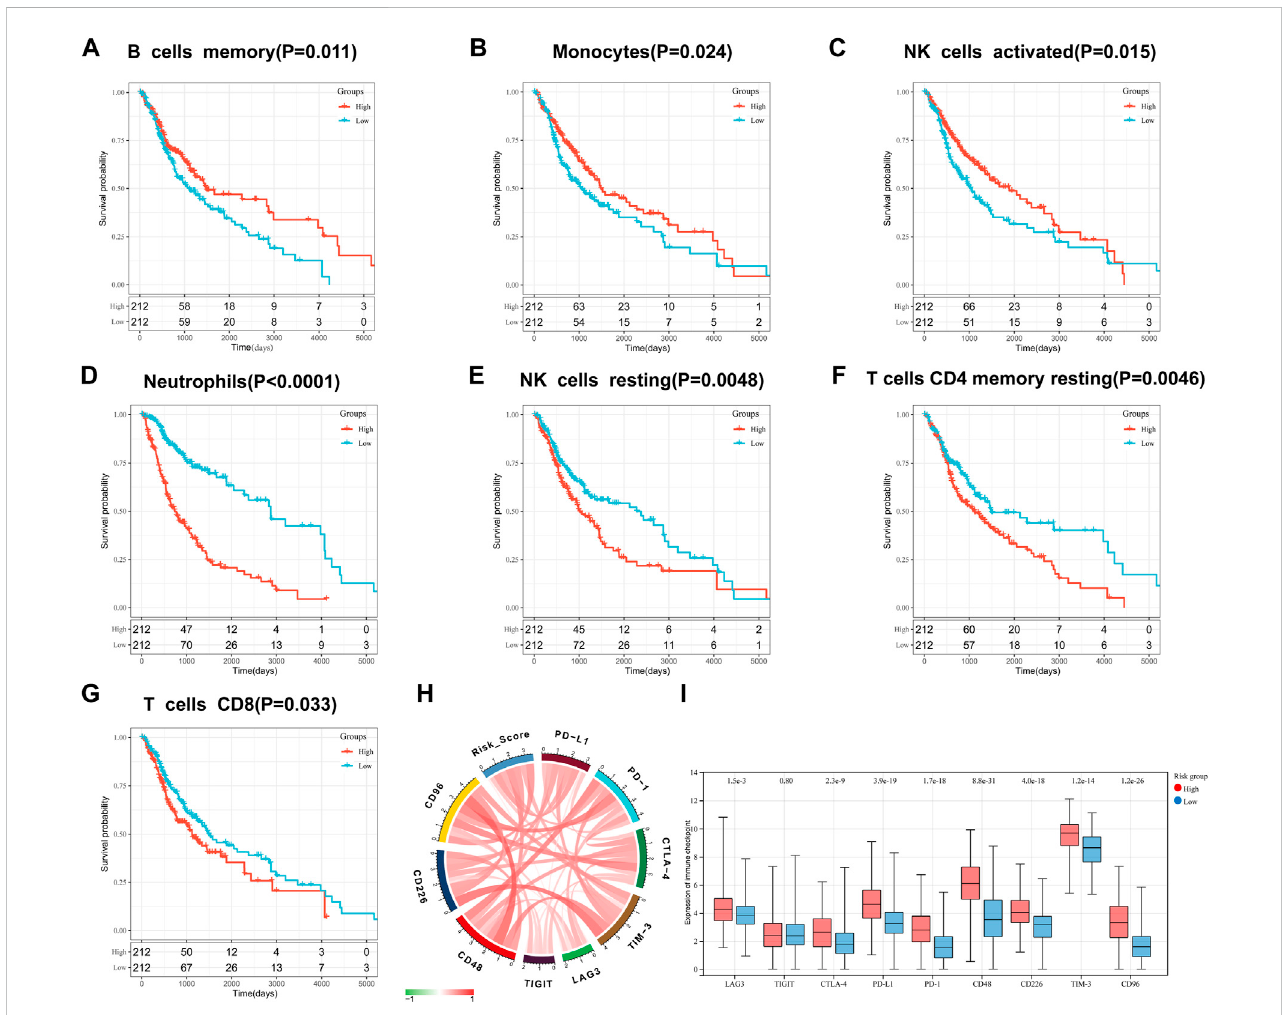
FIGURE 7 Prognostic value of in fi ltrating immune cells: memory B-cell (A) , monocytes (B) , activated NK cells (C) , neutrophils (D) , resting NK cells (E) , resting CD4 memory T-cell (F) , and CD8 T-cell (G) . Correlation between IFN- γ -associated gene scoring model and immune checkpoints: (H) Correlation Circos plots. (I) Expression of immune checkpoints in the high and low risk scoring